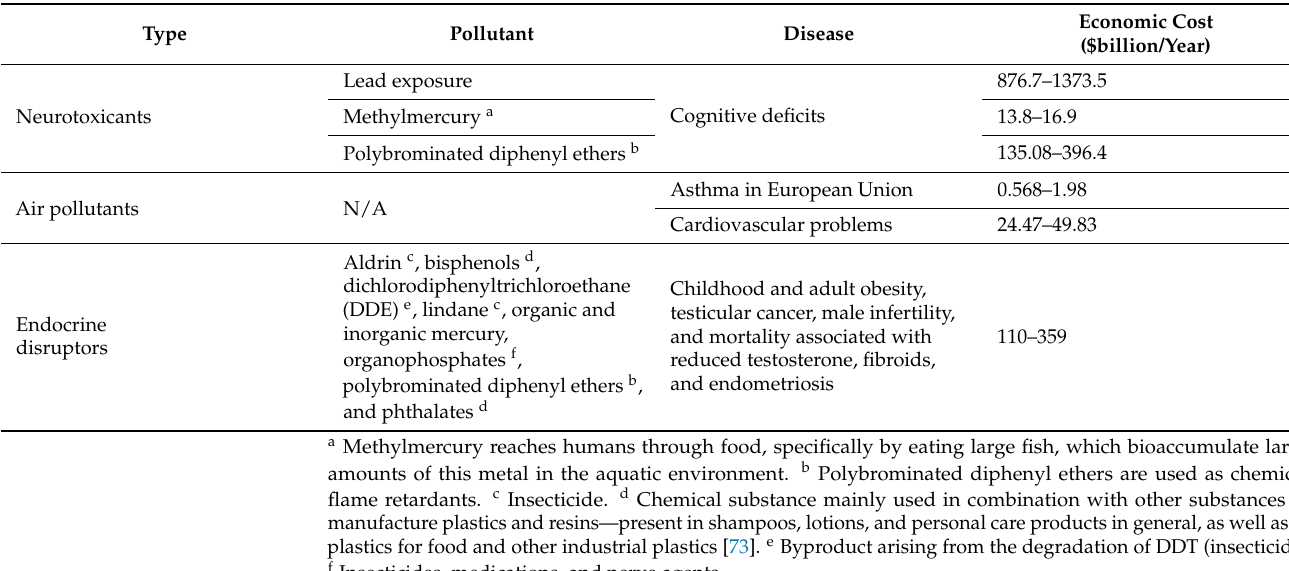
Table 6. Annual costs of population exposure to different types of pollutants, considering costs related to both healthcare and loss of quality of life. Adapted from